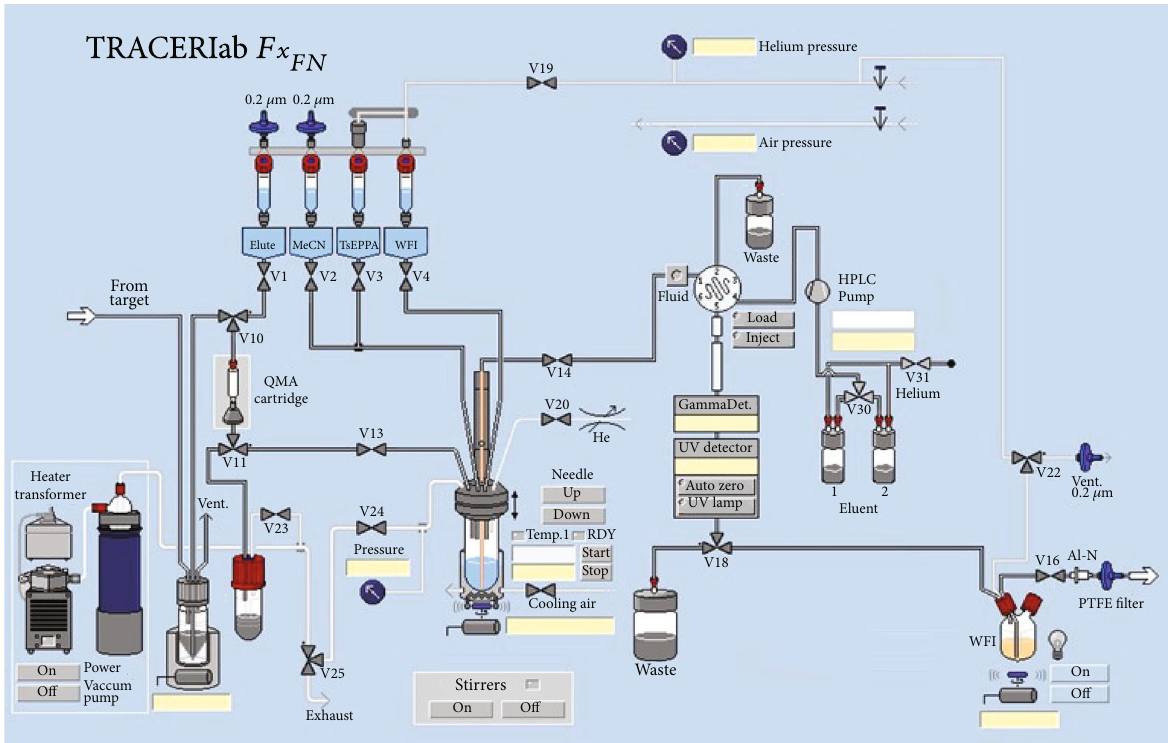
Figure 1: Modi fi ed TRACERLab Fx